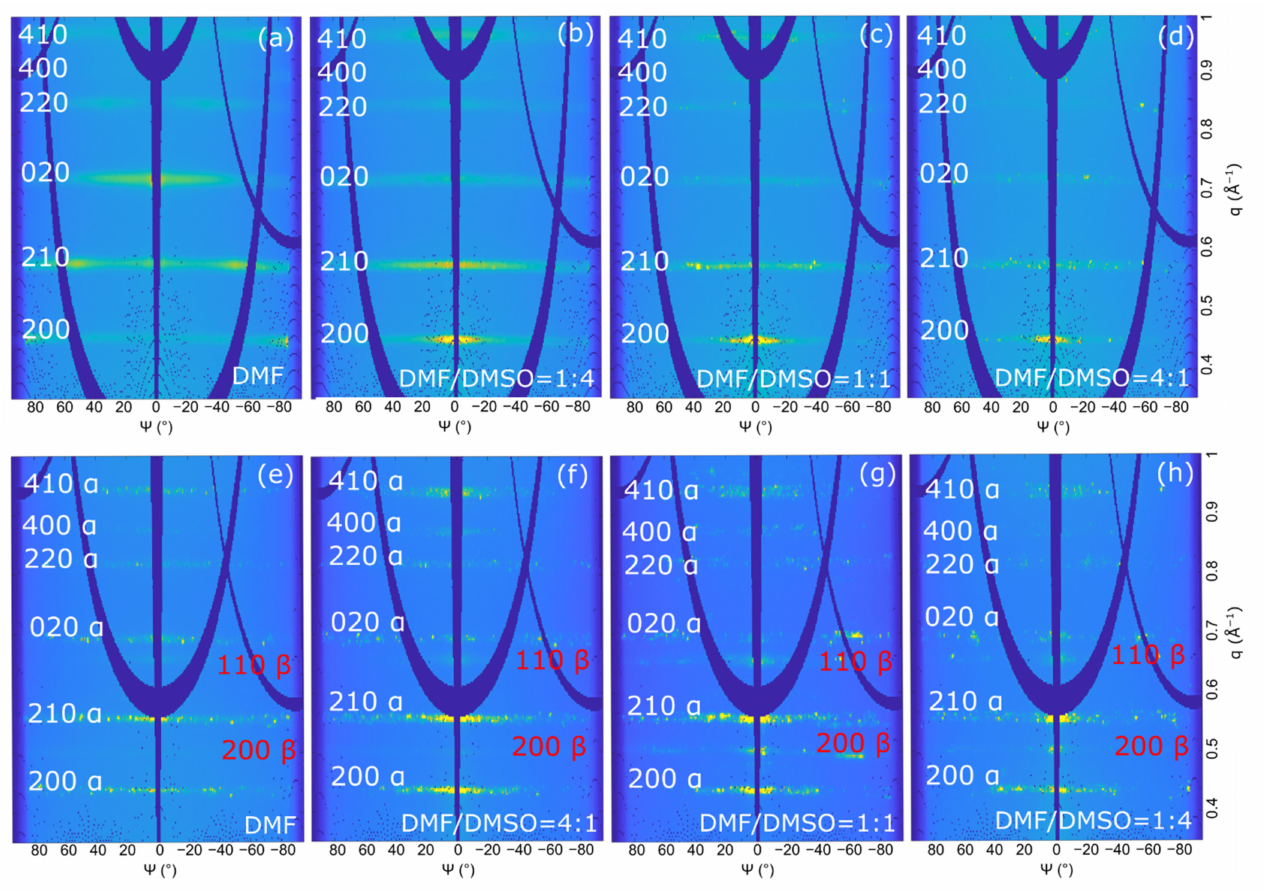
Figure 6. Polar images of the (PRSH)PbBr 3 ( a – d ) and (PRSH)PbI 3 ( e – h ) films prepared with different DMF/DMSO volume ratios, computed starting from the 2D-GIXD images reported in Figures 3 and 4,